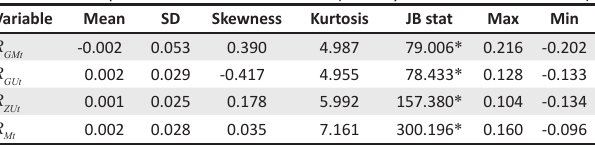
TABLE 3: Correlation matrix for the full period (February 2006 to December 2013).